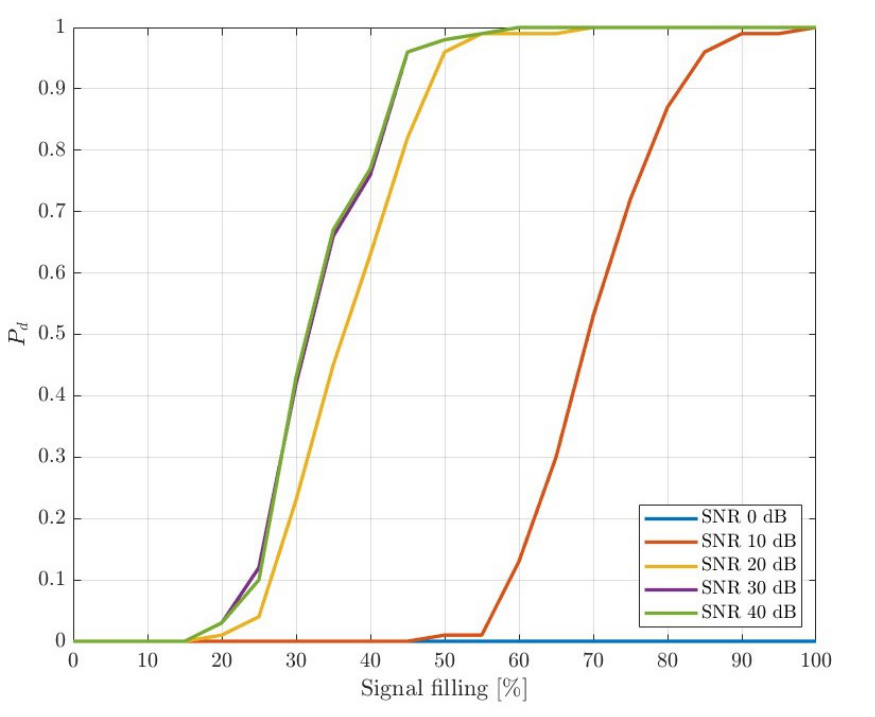
Figure 17. Probability of detection as a function of signal filling, P fa = 10 − 8